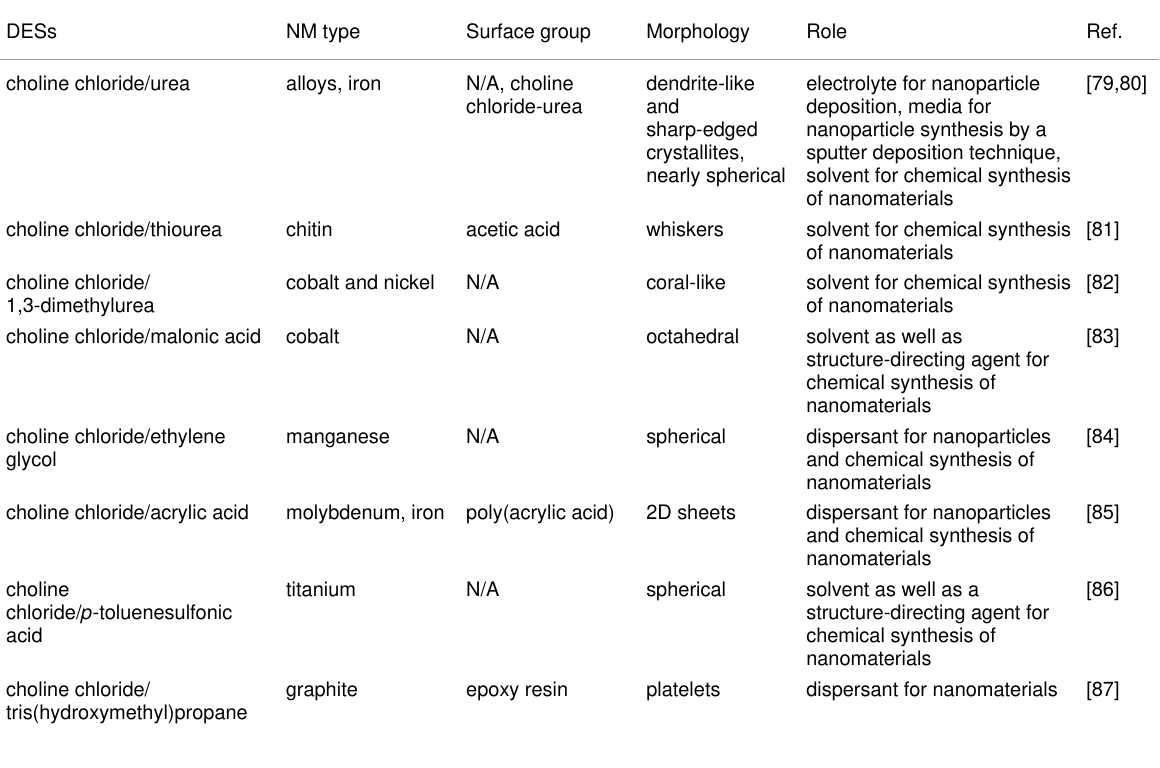
Table 2: Different DESs and their application in the synthesis of nanomaterials (NMs).